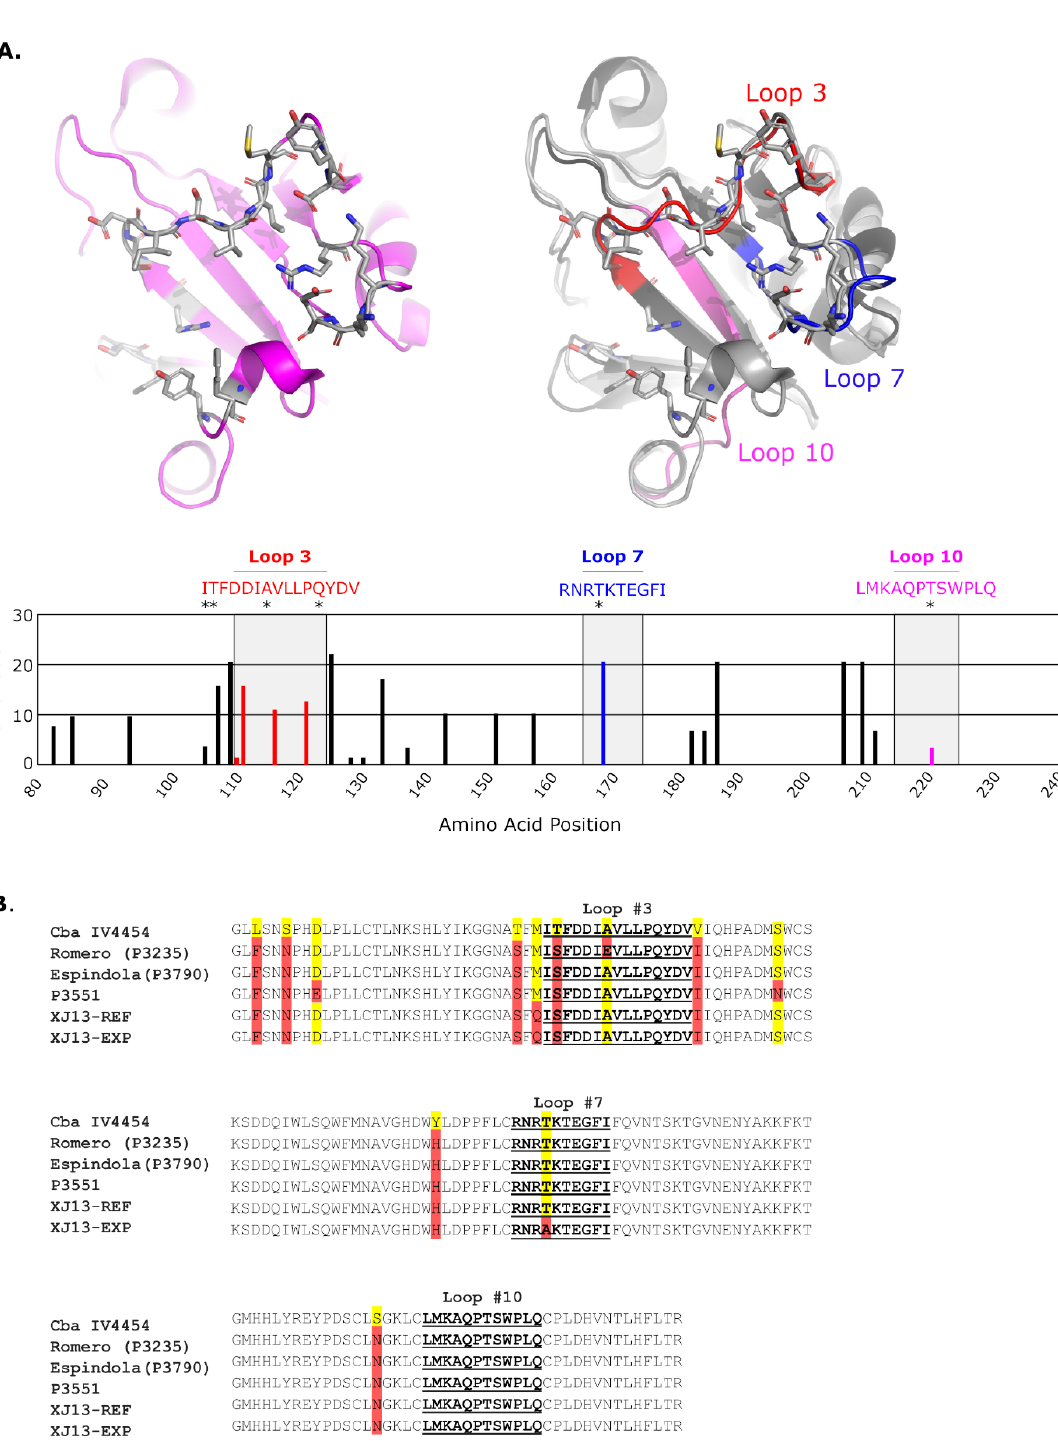
Figure 1. Strategy for the generation of Junín virus (JUNV)-derived peptide antigens for expression on hepatitis B virus core-like particles. ( A ) Crystal structures of Machupo virus (MACV) GP1 and JUNV GP1. The X-ray structure of MACV GP1 in complex with transferrin receptor 1 (TfR1) (PDB:3KAS [11]), in which the TfR1 atoms were removed, is represented in the left panel. GP1 is colored pink except for the residues making contact with TfR1 in the complex, which are shown as sticks (color coded according to the atom type: carbon, light grey; nitrogen, blue; oxygen, red; sulfur, yellow). The right panel shows an overlay of the same structure with JUNV GP1 (extracted from the X-ray structure of JUNV GP1 in complex with Fab GD01, PDB:5EN2 [12]). The MACV GP1 structure is represented with its interacting residues as sticks, as in the left panel, except that the rest of the